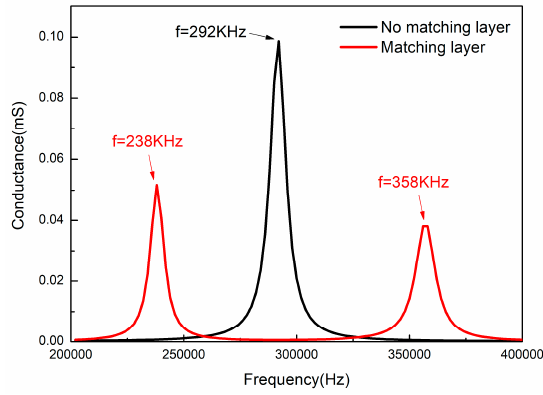
Figure 8. The conductance curves obtained from the simulation of two models.